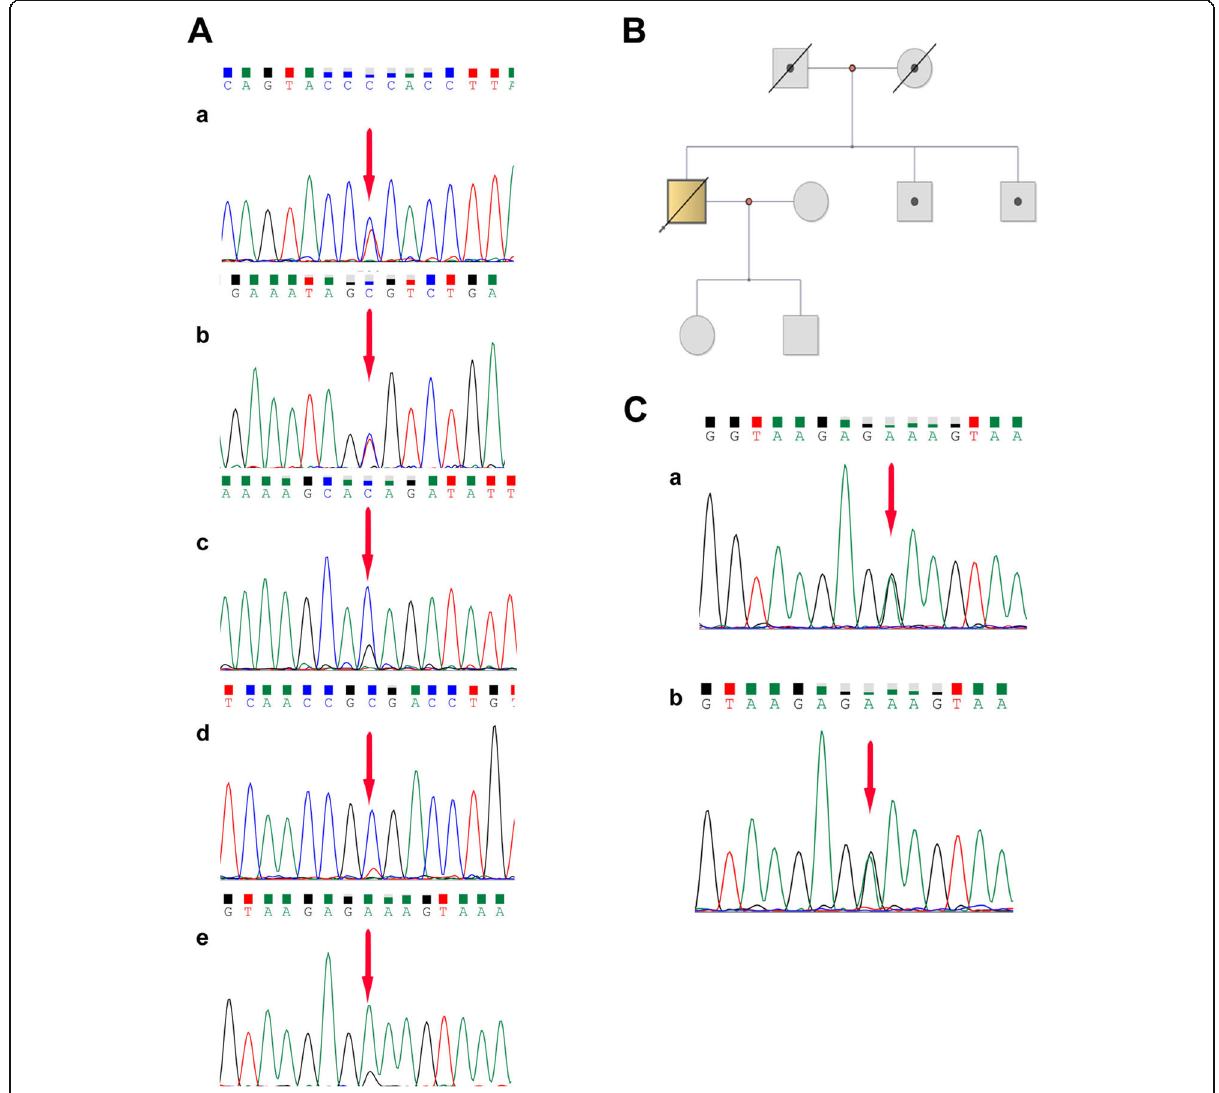
Fig. 6 Germline heterozygous mutations in the proband and pedigree screening. A. a. FANCI (chr15.exon4:c.C257T:p.A86V); b. FANCI (chr15.exon22:c.G2225C:p.C742S); c. FANCJ/BRIP1 (chr17.exon19:c.T2755C:p.S919P), d. FANCA (chr16.exon9:c.A796G:p.T266A); e. FAN1 (chr15.exon2:c.G 698A:p.G233E) (corresponding non-tumor liver tissue). B. Pedigree map: the proband ’ s parents died from cardiovascular and cerebrovascular diseases; there was no obvious Fanconi ’ s anemia disease in the proband ’ s offspring and brothers. C. Siblings A and B, FAN1 (exon2:c.G698A:p.G233E)